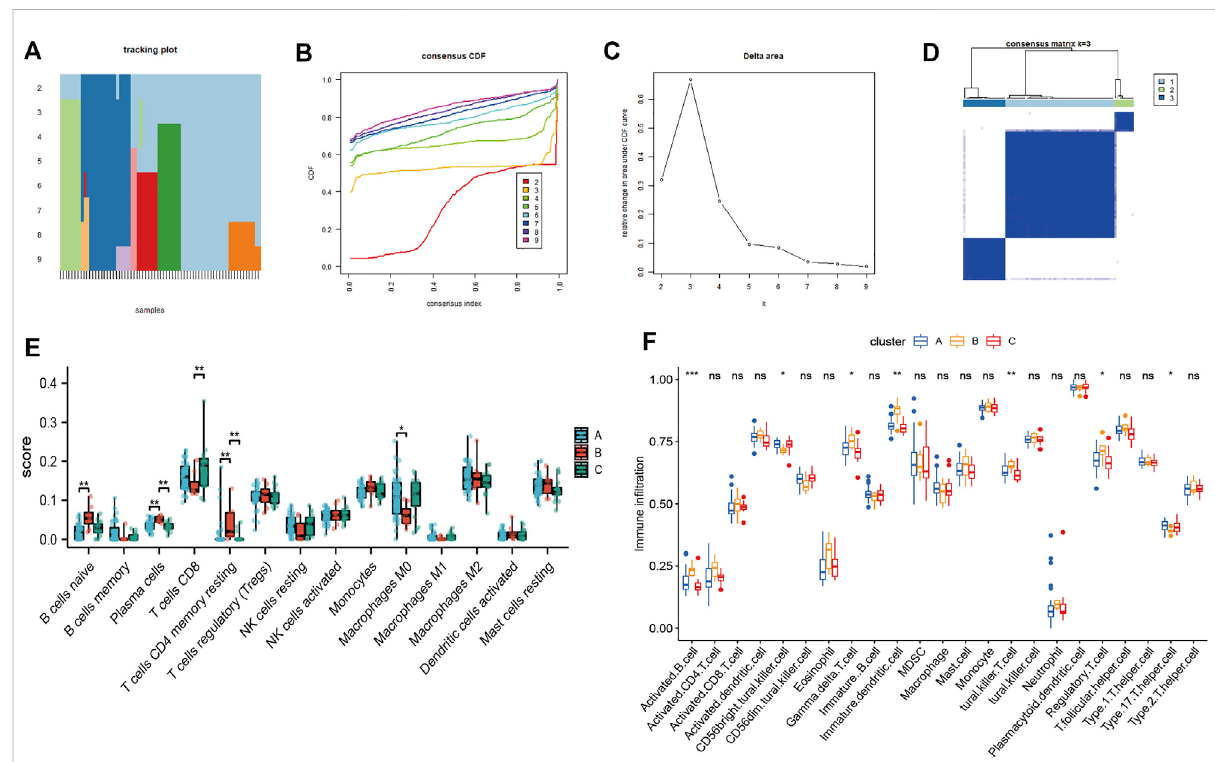
FIGURE 10 Consensus clustering analysis of OSA subjects based on mitochondrial dysfunction-related genes and analysis of immune cell in fi ltration. (A) Tracking plot of consistent clustering. (B) Consensusclustering cumulative distribution function (CDF) for k = 2 – 9. (C) Relative change in area under CDF curve for k = 2 – 7. (D) OSA subjects were divided into three clusters when k = 3. Boxplots of degree of immune cell in fi ltration among clusters A – C, based on (E) CIBERSORT and (F) ssGSEA